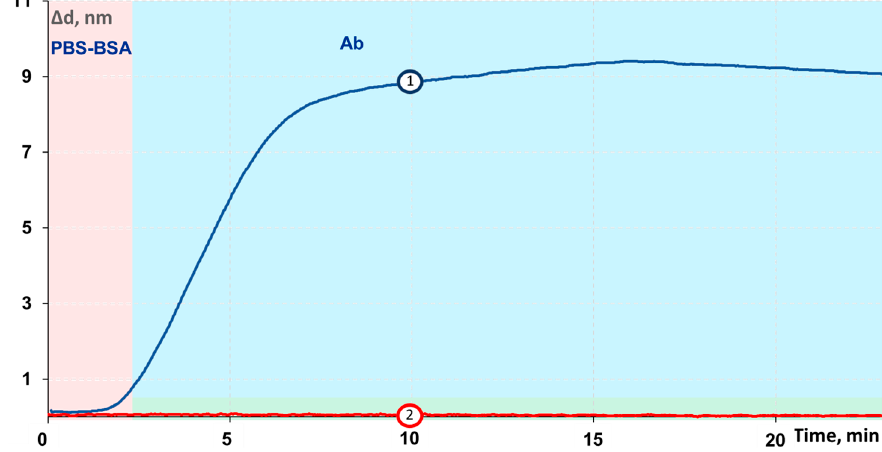
Figure 8. Comparison of the sensorgrams obtained in the negative control studies: 1—sensorgram obtained with samples containing FA antibody; 2—typical sensorgram that demonstrates the absence of non-specific binding with passing the solutions of PBS-BSA or one of the following substances: chloramphenicol, thyroxine, ochratoxin A, or large protein molecules—HBsAg, PSA, cTnI, or HSA.